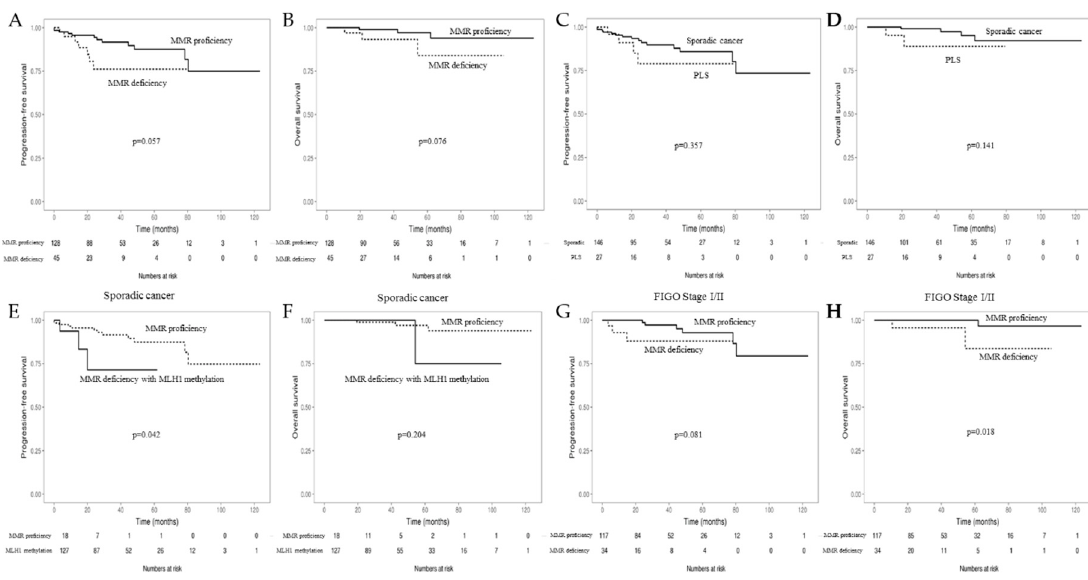
Figure 4. Kaplan–Meier curves for progression-free survival (PFS) ( A ) and overall survival (OS) ( B ), according to the practical molecular classification of endometrial cancer, based on DNA mismatch repair (MMR) status and p53 staining results in endometrial cancer patients. Kaplan–Meier curves for progression-free survival (PFS) ( C ) and overall survival (OS) ( D ), according to the practical molecular classification of endometrial cancer based on probable Lynch syndrome (PLS) status and p53 staining results in endometrial cancer patients.